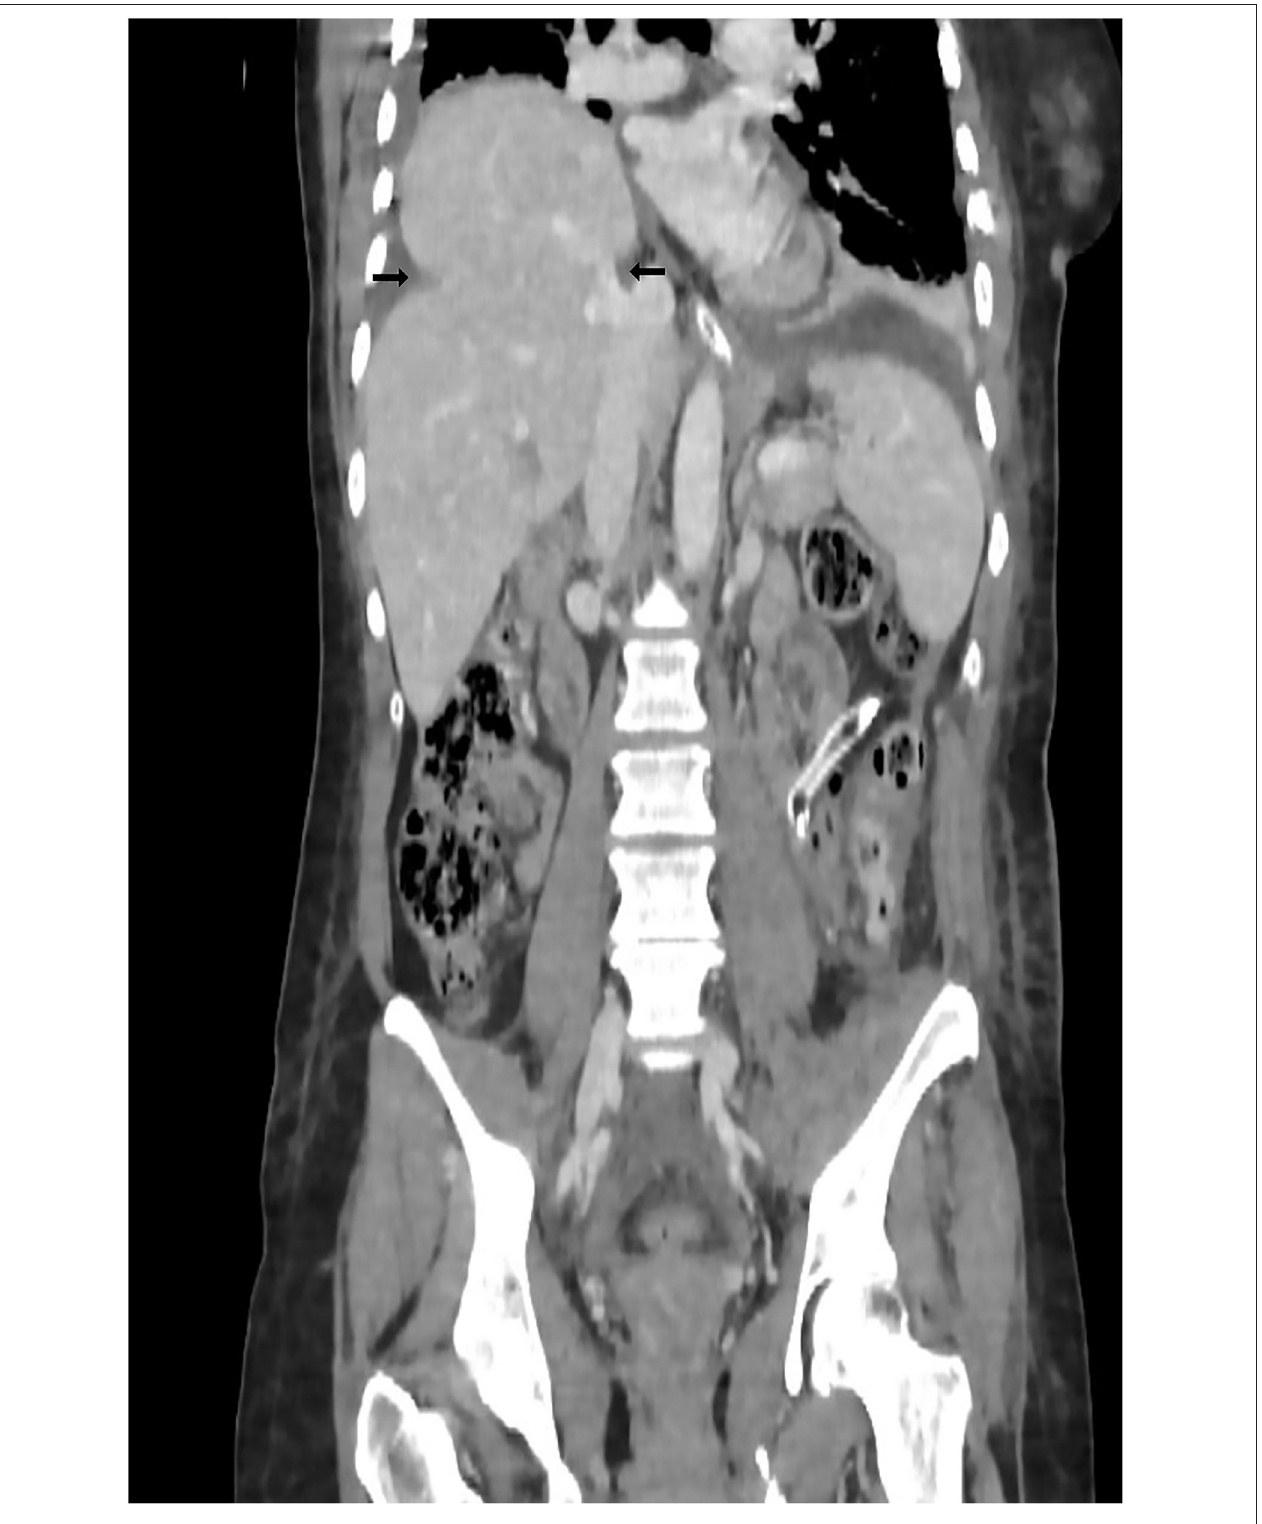
FIGURE 2 | Fourth postoperative day Thorax-Abdomen contrast-enhanced CT that showed the raising of the right liver dome and collar sign (black arrows) with herniation of the VII and VIII liver segments.